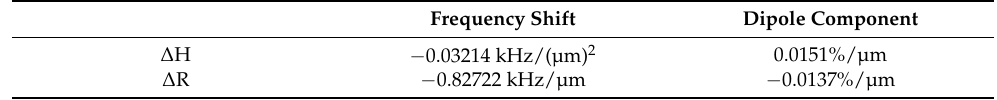
Table 9. Dipole component and frequency shift due to structurl